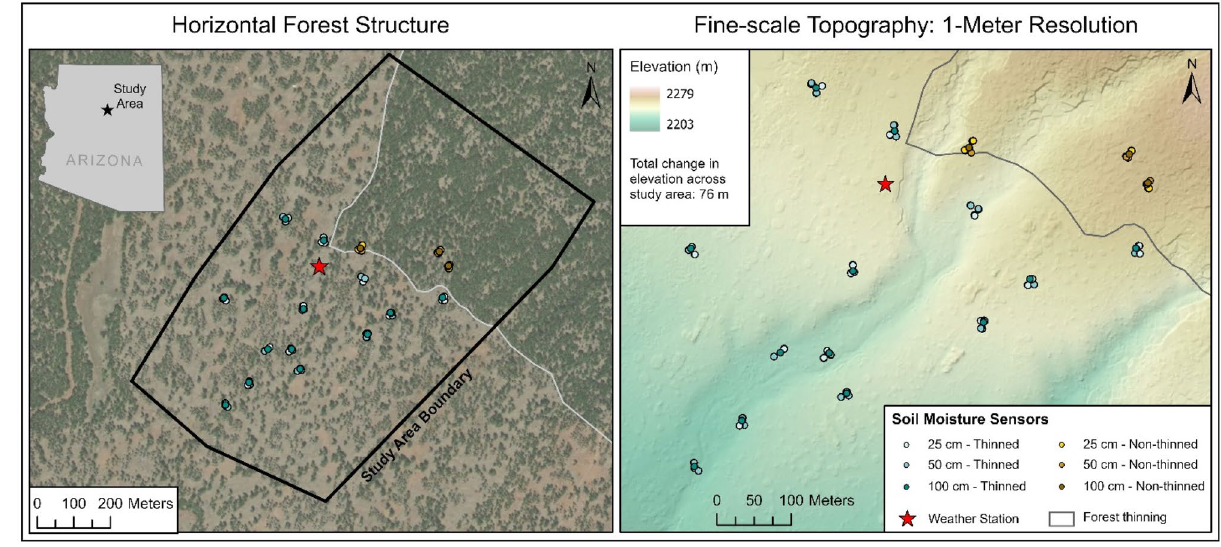
Figure 7. Study area (83 ha, outlined with a black line in the left panel) in northern Arizona that was thinned as part of the regional forest restoration effort. The soil moisture sensor network includes 93 sensors that measure hourly soil water potential and a zoomed-in view of their distribution is shown in the right panel. The entire 83 ha study area (outlined with a black line in the left panel) was imaged with the UAV thermal sensor